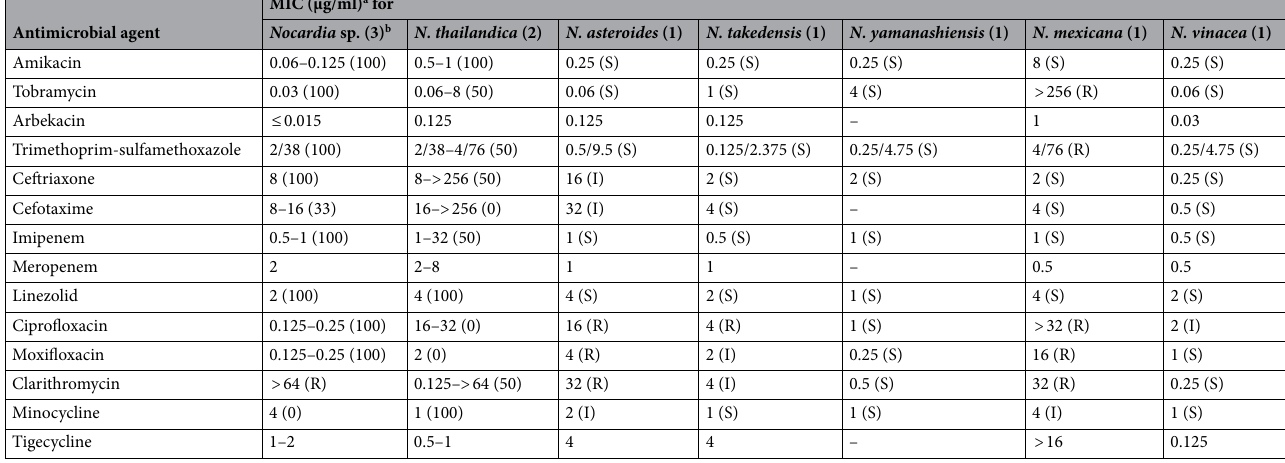
Table 3. Activities of antimicrobial agents against 10 clinical isolates of uncommon Nocardia species. a The MIC range is shown, with the percentage of susceptible isolates or susceptibility category (S, susceptible; I, intermediate; R, resistant) in parentheses. The number of isolates for each species is shown in parentheses. b 2/3 isolates were identified as N. testacea / N. sienata , and 1/3 isolates was identified as N. testacea / N. flavorosea / N. sienata / N.rhamnosiphila by full-length 16S rRNA gene sequencing.